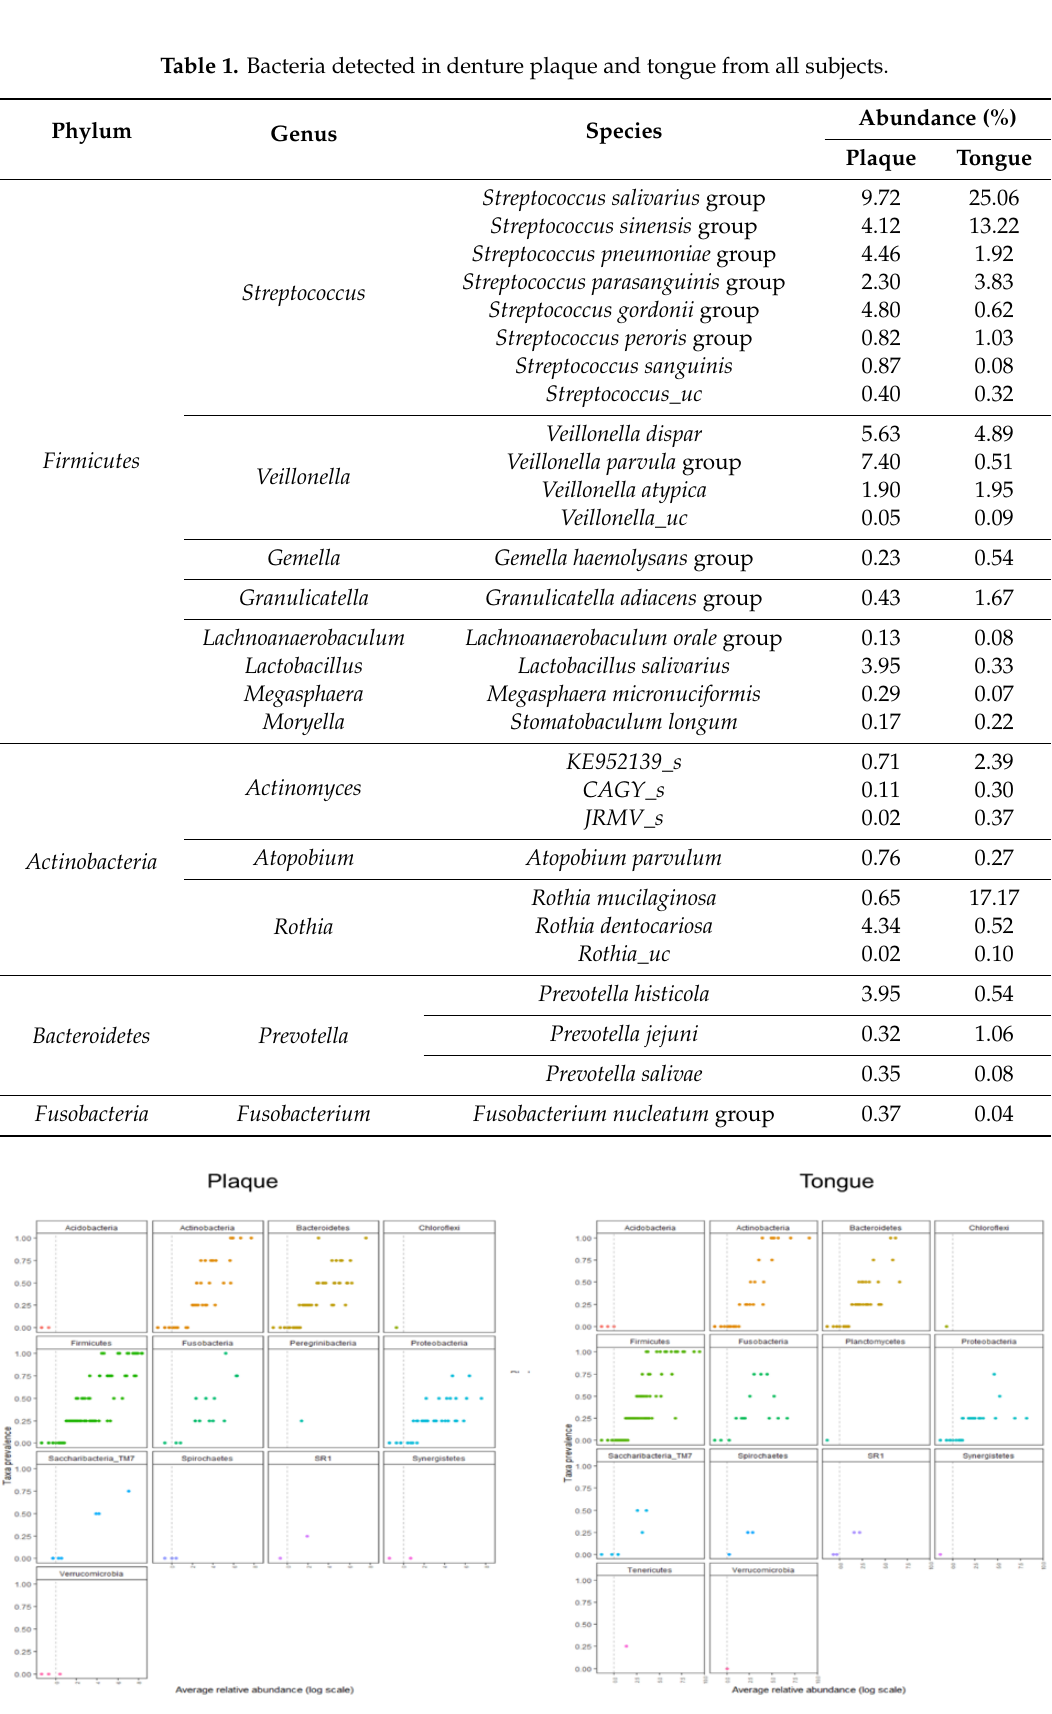
Figure 2. Prevalence of taxa in terms of abundance for 14 different phyla.